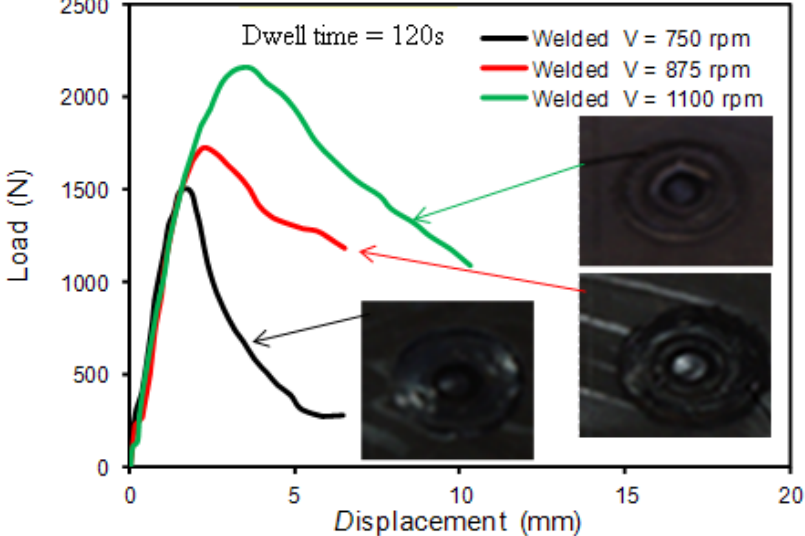
Figure 8: Load-displacement curve, effect of rotational speed for dwell time =120s